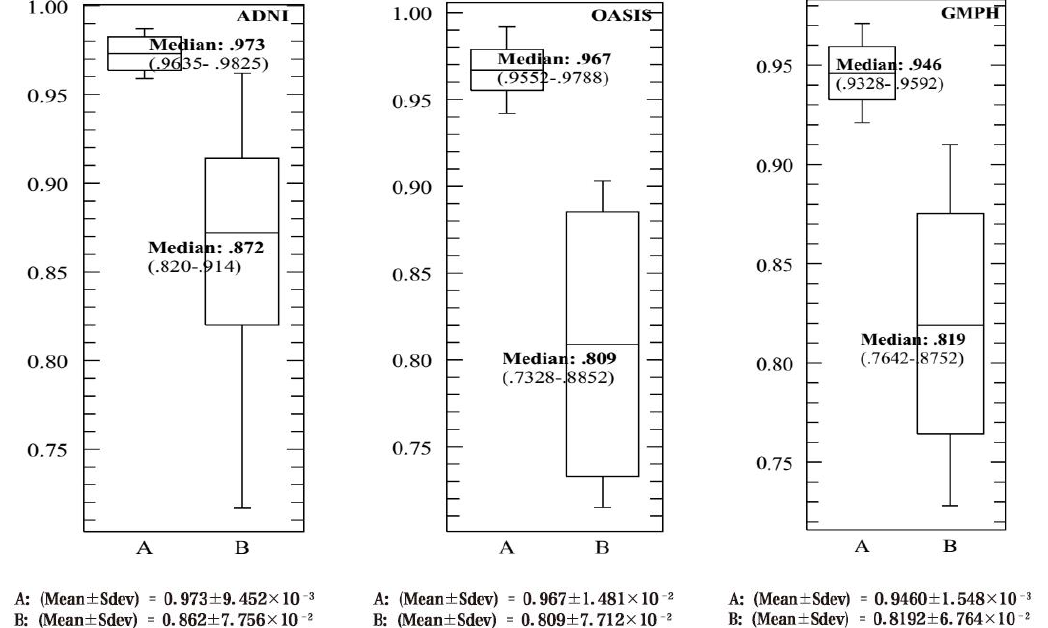
Figure 18. The corresponding Box-and-whisker plots of the descriptive statistics of the area under